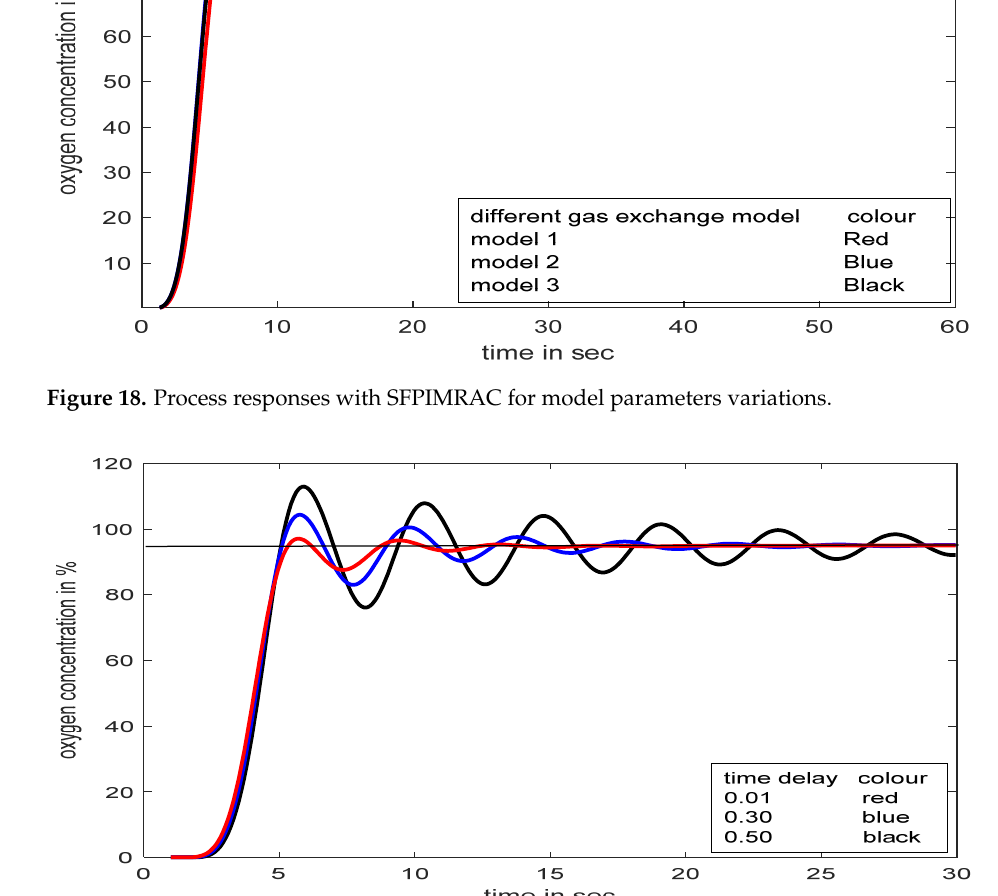
Figure 19. Process responses with SFPIMRAC with different time